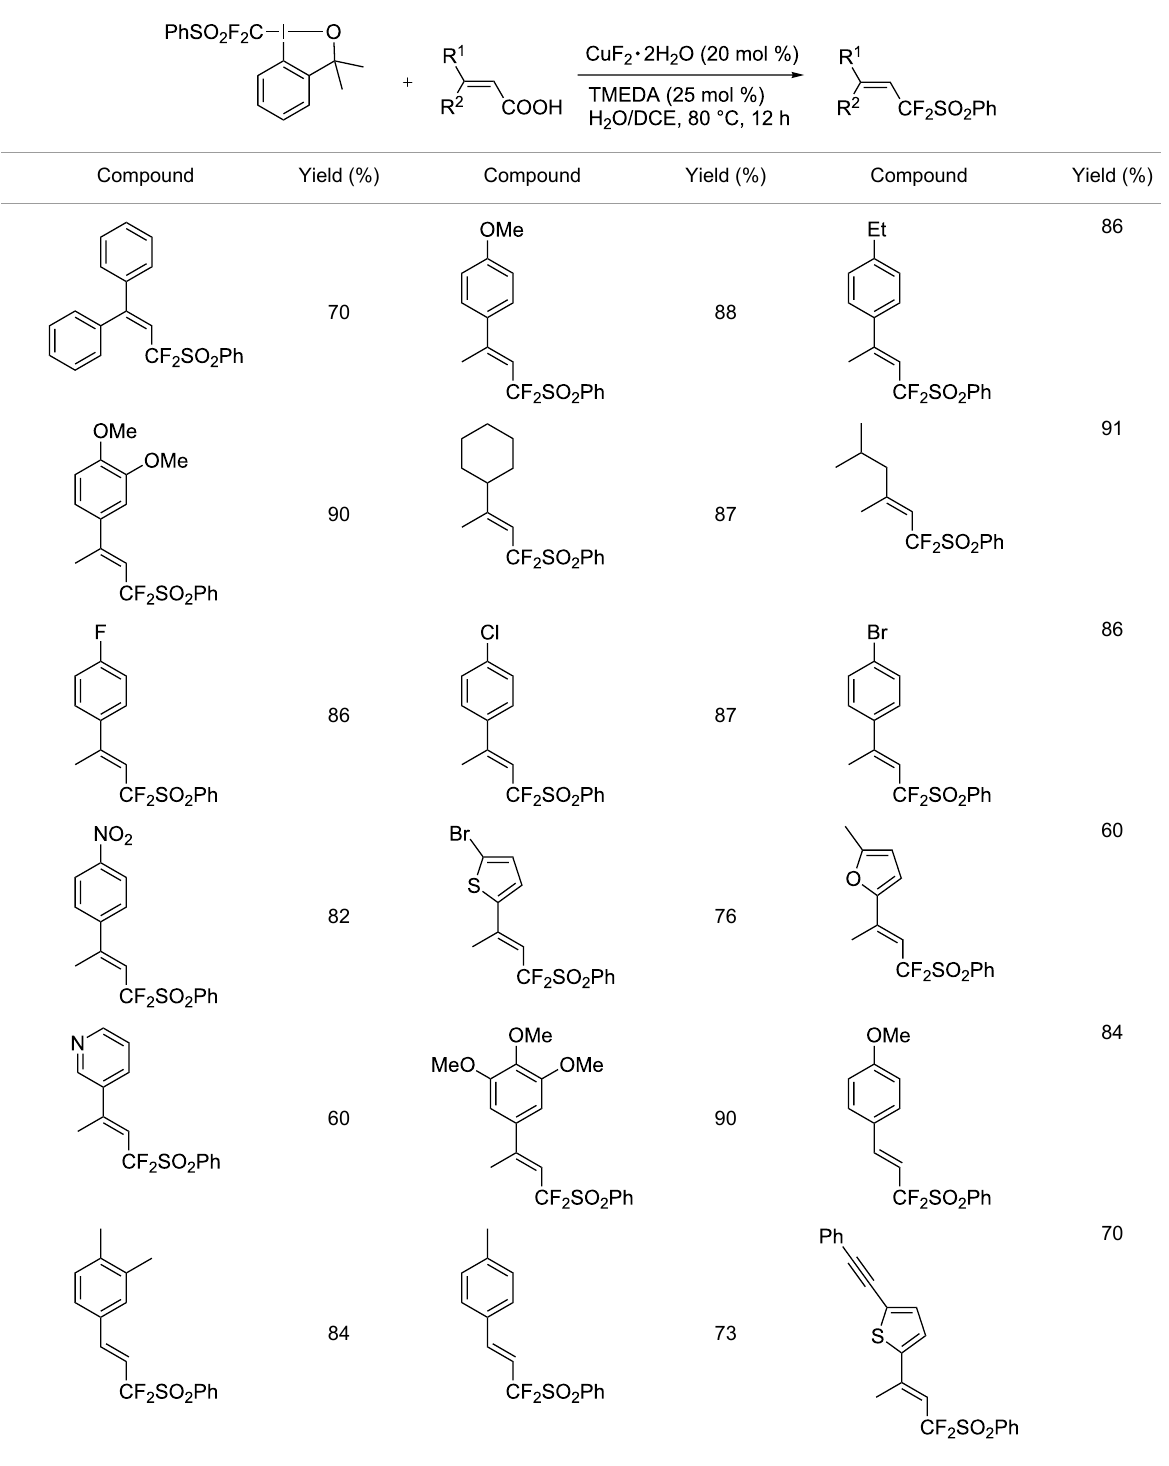
Table 1: Cu-catalyzed C–CHF 2 bond formation of α , β -unsaturated carboxylic acids through decarboxylative fluoroalkylation [61].